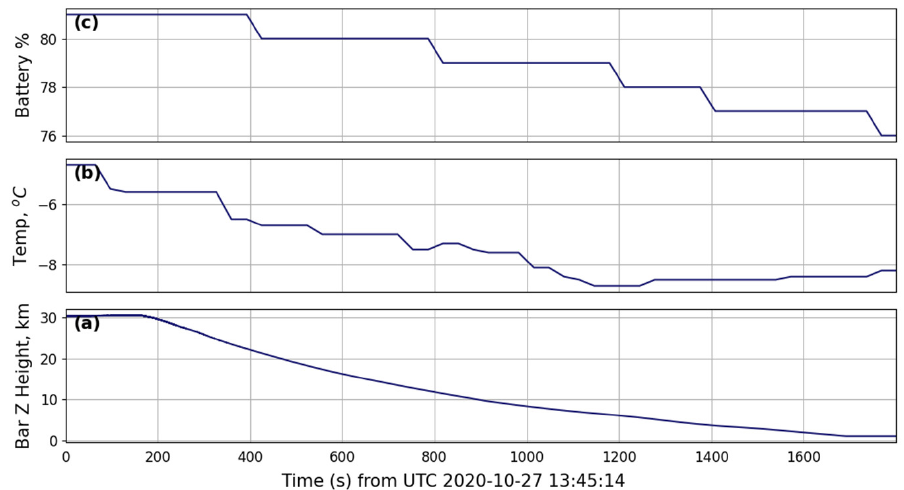
Figure 11. Power status during Skyfall descent showing ( a ) height inferred from the barometer pressure during fall, ( b ) temperature, and ( c ) remaining battery percentage.